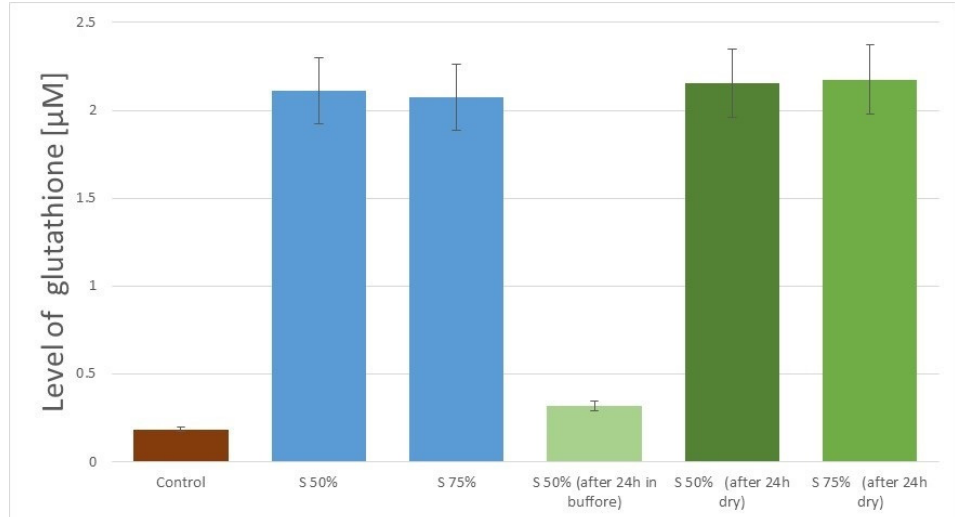
Figure 7. Amount of adhered glutathione to activated graphene surface by sulfuric acid (S50%—50% sulfuric acid, S75%—75% sulfuric acid).